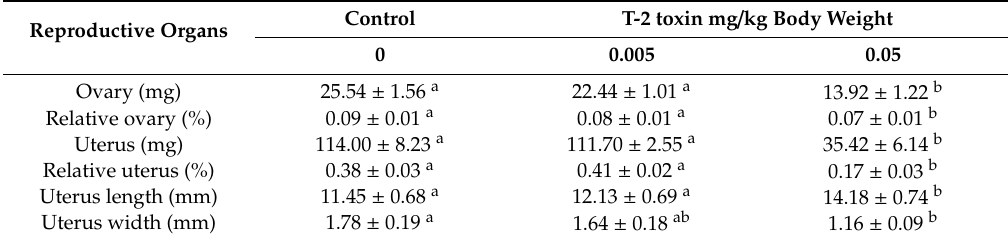
Table 3. Absolute (mg) and relative (%) reproductive organ weight of female mice after three consecutive estrus cycles, whose dams were orally administered with T-2 toxin at 0, 0.005, and 0.05 mg / kg from gestational day 14 (GD 14) to lactational day 21 (LD 21).